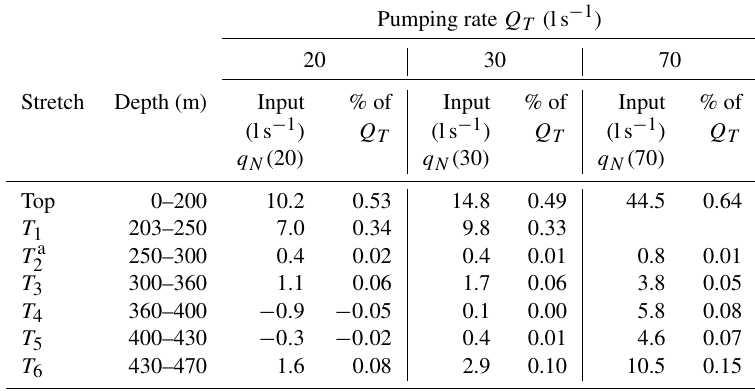
Table 3. Water inputs of flow stretches for different pumping rates and fractions over the total flow rate Q T in the case